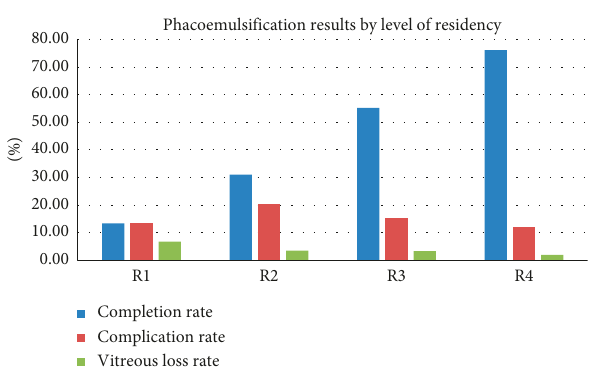
Figure 2: Surgical results of phacoemulsification by the level of